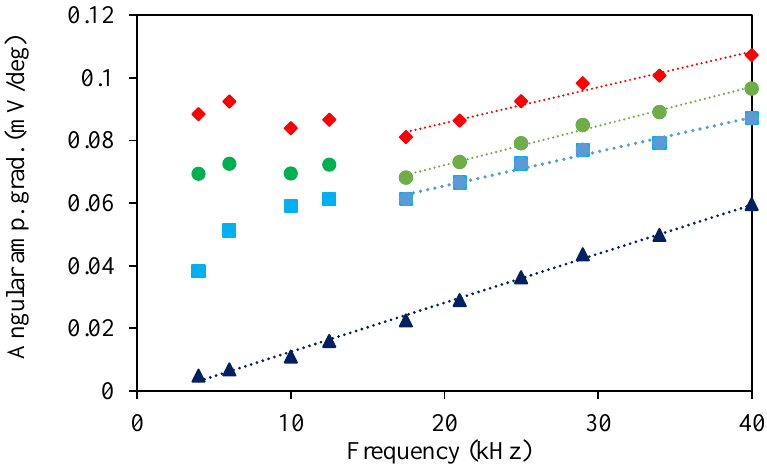
Figure 8. Gradient of the angular signal dependence as a function of the operating frequency recorded for stainless steel (dark blue triangles), brass (green dots), aluminium (blue squares), and copper (red diamonds) plates. The dotted line represents a linear fit to the dependence and indicates the frequency regime where the signal growth is dominated by the induction frequency dependence.